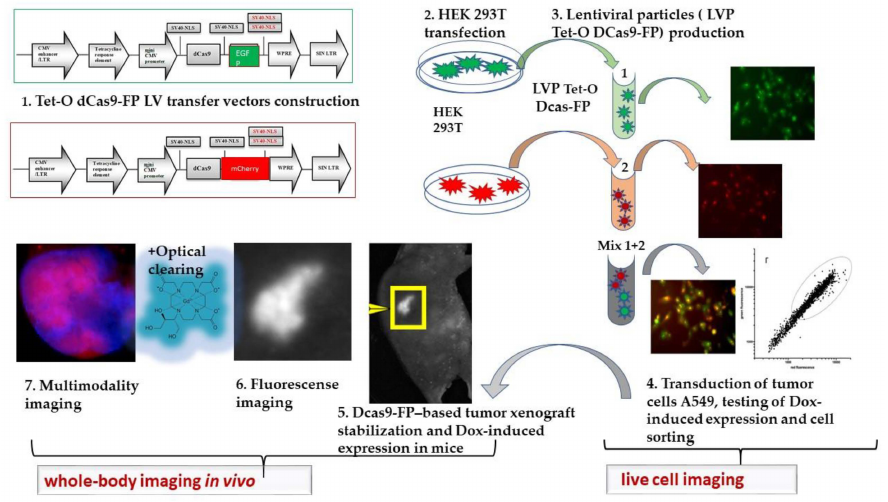
Figure 7. Optimized protocol for dCas9-FP chimera generating, monitoring of Tet-On expression in vitro and in vivo followed by FI and FRET measurements and MRI.